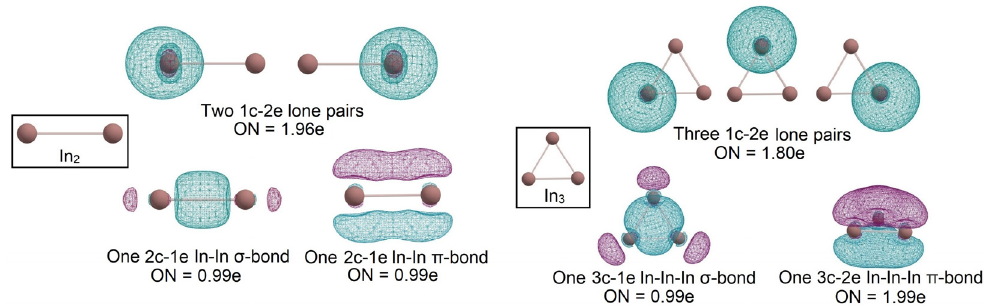
Figure 2. The chemical bonding pattern of In 2 and In 3 global minimum structures obtained by AdNDP analysis.